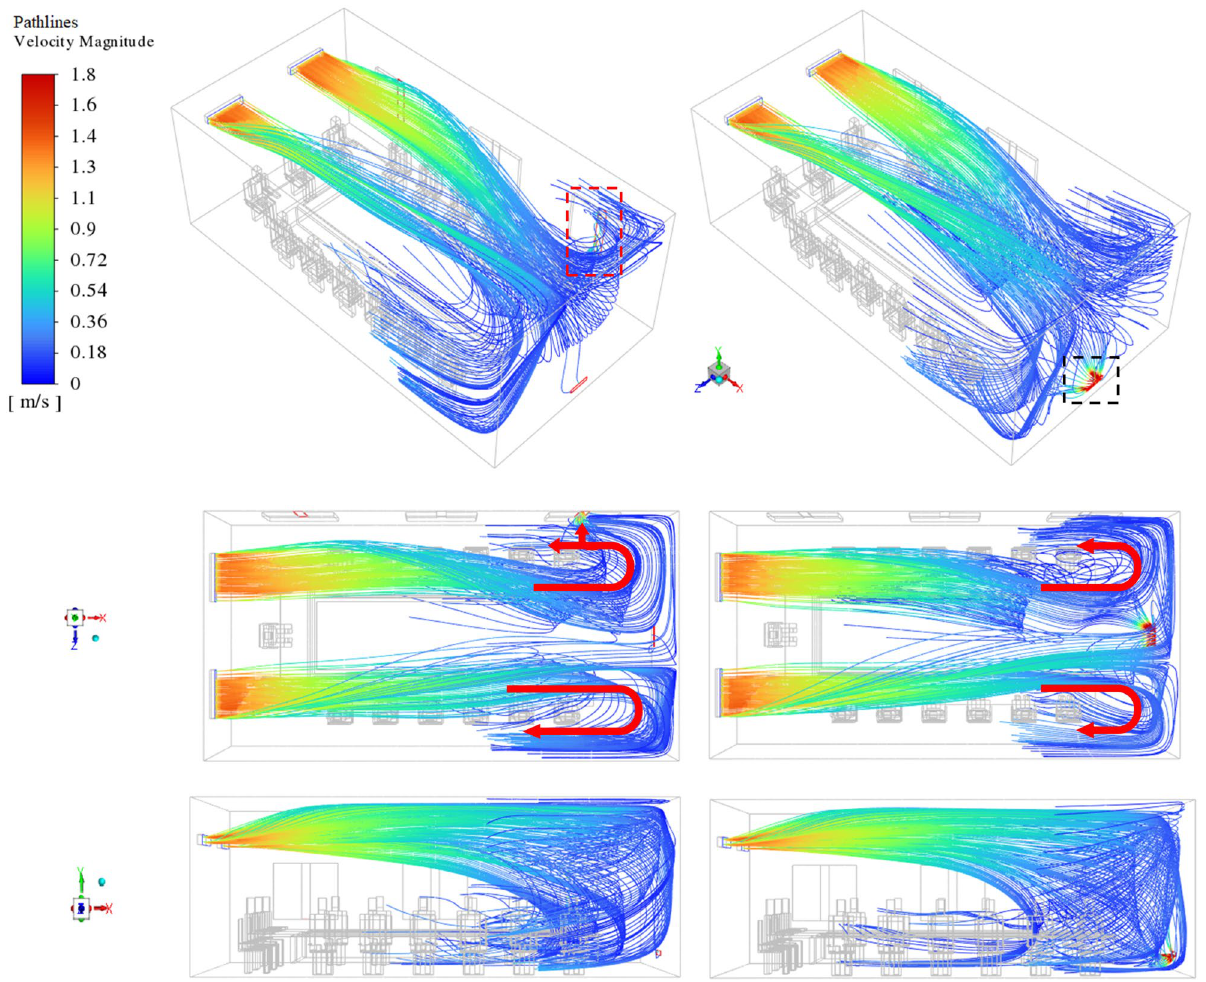
Figure 8. Generated velocity path lines inside domain from air supplies; left side: windows 1 and 3 be open, and the right side: all the windows, be airflow paths to exhaust, the difference between the scenarios becomes more apparent. When all windows are closed, the concentration of path lines adjacent to the equalizer, as the only output path in this scenario, increases dramatically (black dashed bar in Fig. 8). Resulting in creating the relative symmetry between the inverse-path lines that can be seen nearing both sidewalls. In contrast, by opening the window(s) and increasing the airflow output capacity, the path lines tend to exit through the windows rather than equalize (red dashed bar in Fig. 8). For two main reasons, first, the window area is larger than the equalizer, and the windows are in a higher position relative to the equalizer, which leads to the approaching of the flow paths. Consequently, the created paths are asymmetric, unlike in the previous case. This behavior has been specified with the red arrows in Fig. 8. The location of the air supplies is another important parameter that has a significant effect on the field of airflow velocity and thus the spread of viral particles. To clarify this influence, a comparison has been made in Fig. 9 between the height and direction of the air supplies. The most distinctive point is that the direct distance traveled by the produced jet stream in Fig. 9a is longer than in Fig. 9b. It can be attributed to the distance between the windows and the ceiling. It implies that by reducing the height of the room from 3.5 to 3 m, the distance between the windows and the produced jet of airflow is also decreased. And regarding the pressure and tempera- ture difference between the open windows’ surfaces and airflow streamlines and the resulting of tendency the streamlines to exchange momentum and energy, leads to observing this difference. Which causes a significant difference in the deposition and suspension of aerosols. Figure 10a–c show the isometric views of the velocity field, temperature field, and RH variations at Z = 2 and 4.9 m during scenario 1 (all windows are open). As illustrated, in the upper regions, the value of these three flow characteristics is higher than in the lower regions. This is due to the loss of momentum and energy of the incoming airflow, which occurs by moving to the lower parts. In Fig. 11 two different planes are selected to analyze the velocity field at Y = 1, and 1.5 m. As shown, the velocity field around people is such that it meets the needs of thermal comfort. However, the air velocity on the windows side is slightly slower than on the opposite side. It can be attributed to the decrease in the momentum and energy of the generated jets by exiting from the windows.